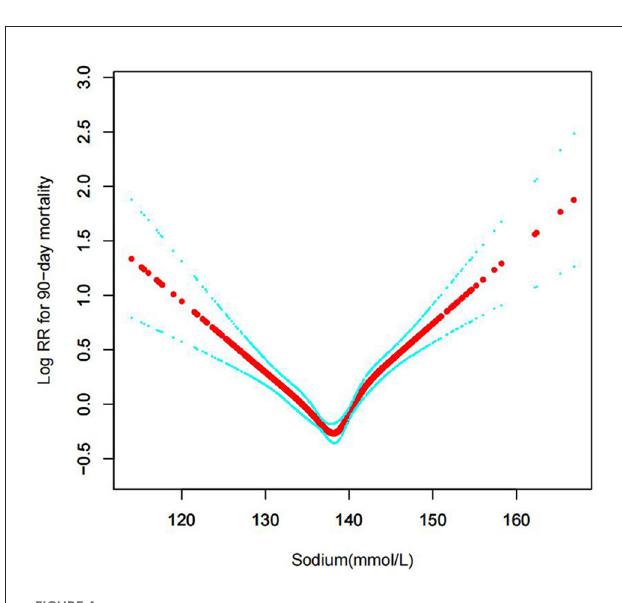
FIGURE6 Association between serum sodium levels and 4-year all-cause mortality (Unadjusted